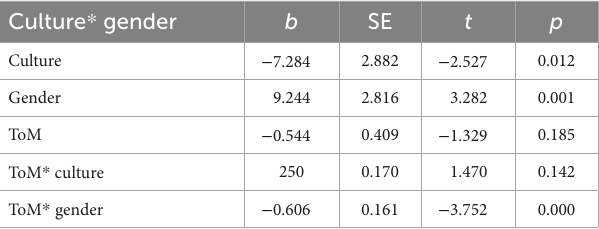
TABLE 6 Moderating role of culture and gender on the relationship between ToM and prosocial behaviour. Culture * gender